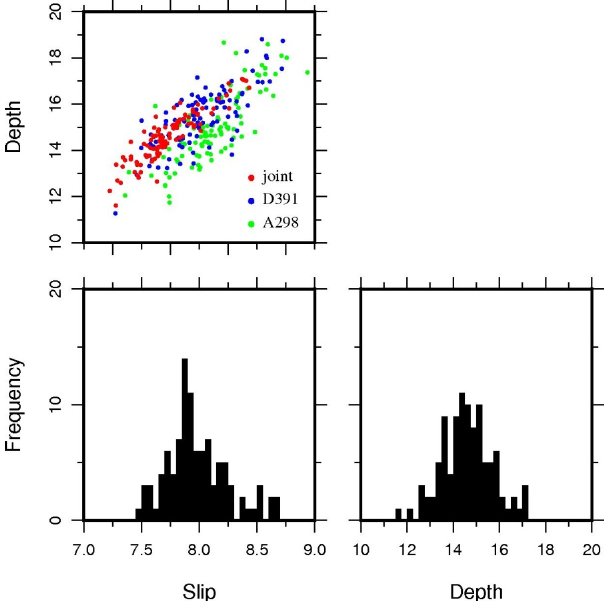
Figure 10. Results from the Monte Carlo error analysis. The red dots represent joint inversion whereas blue (D391) and green (A298) dots represent single inversions. The higher frequencies of slip rate and depth concentrate near 8.0 mm/year and 14.5 km, respectively.